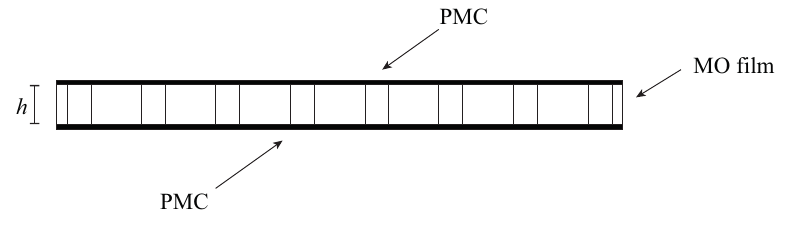
Figure 4. Cross-section of the